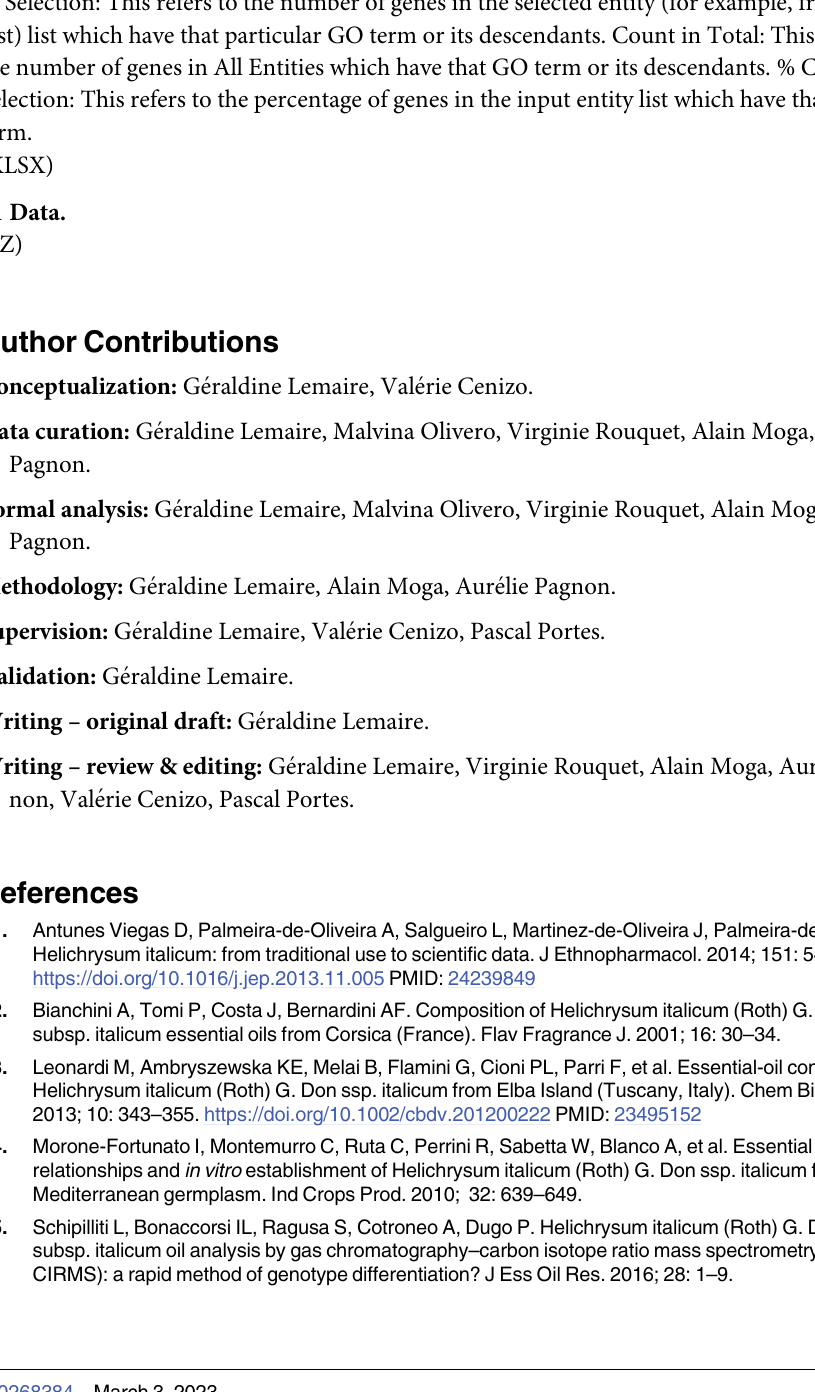
S2 Table. List of the 129 genes only regulated by NA 0.03%. S3 Table. List of the 1,421 genes only regulated by HIEO 0.1%. S4 Table. List of 59 enriched GO terms for biological processes, molecular functions, and cellular components related to 1,008 genes common to NA and HIEO. Corrected p-value: Since multiple GO accession number are tested for their significance, hence a multiple testing correction is performed. The GO spreadsheet is sorted based on the corrected p-values. Count in Selection: This refers to the number of genes in the selected entity (for example, from T- test) list which have that particular GO term or its descendants. Count in Total: This refers to the number of genes in All Entities which have that GO term or its descendants. % Count in Selection: This refers to the percentage of genes in the input entity list which have that GO